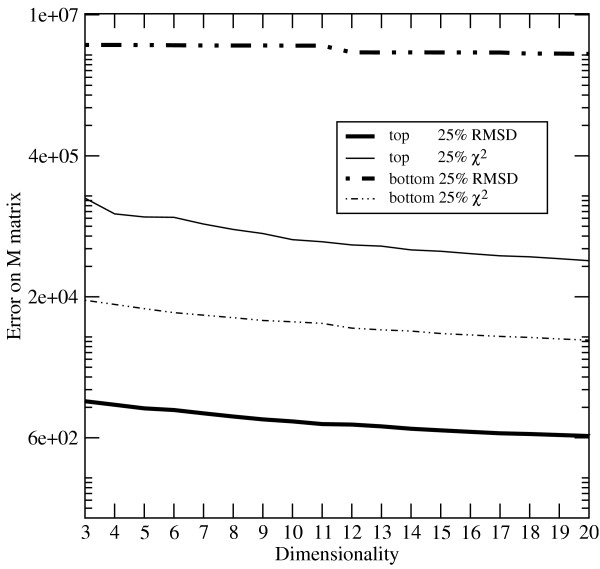
Misfit in M. The error between portions of the M and D matrices is shown as the dimensionality increases for the Rosetta data as fit by LS-NMF. The bottom 25% of the genes in terms of precision (i.e., highest variance) are shown together with the top 25%. Since LS-NMF relies on the variance, the algorithm fits the reliable data with improving accuracy, while ignoring poor data in terms of RMSD as the dimensionality increases.